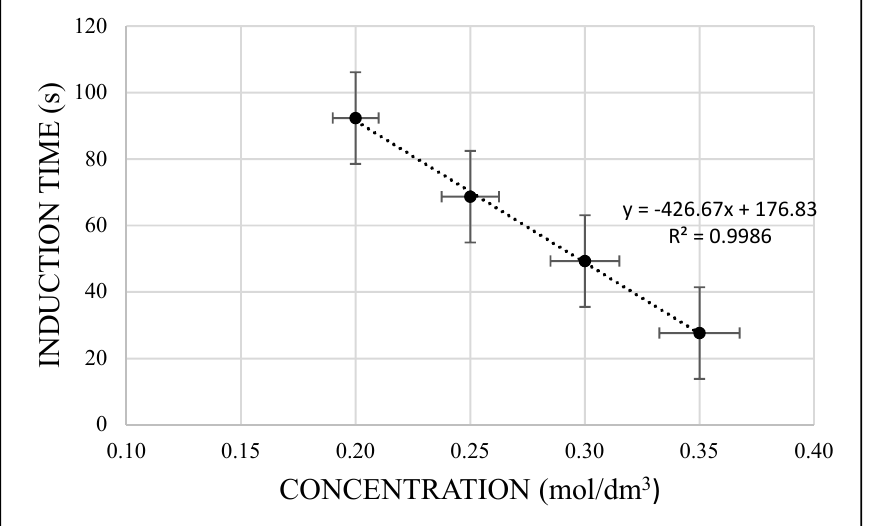
Figure 3. Altered induction time as a function of concentration.